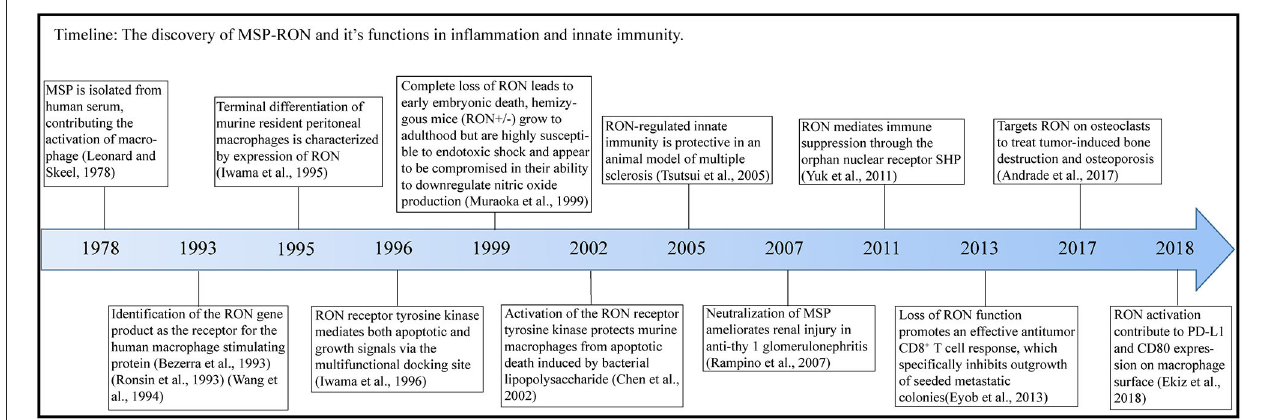
FIGURE 1 | Timeline. In this figure, we illustrate the timeline of MSP-RON discovery and its role in inflammation and innate